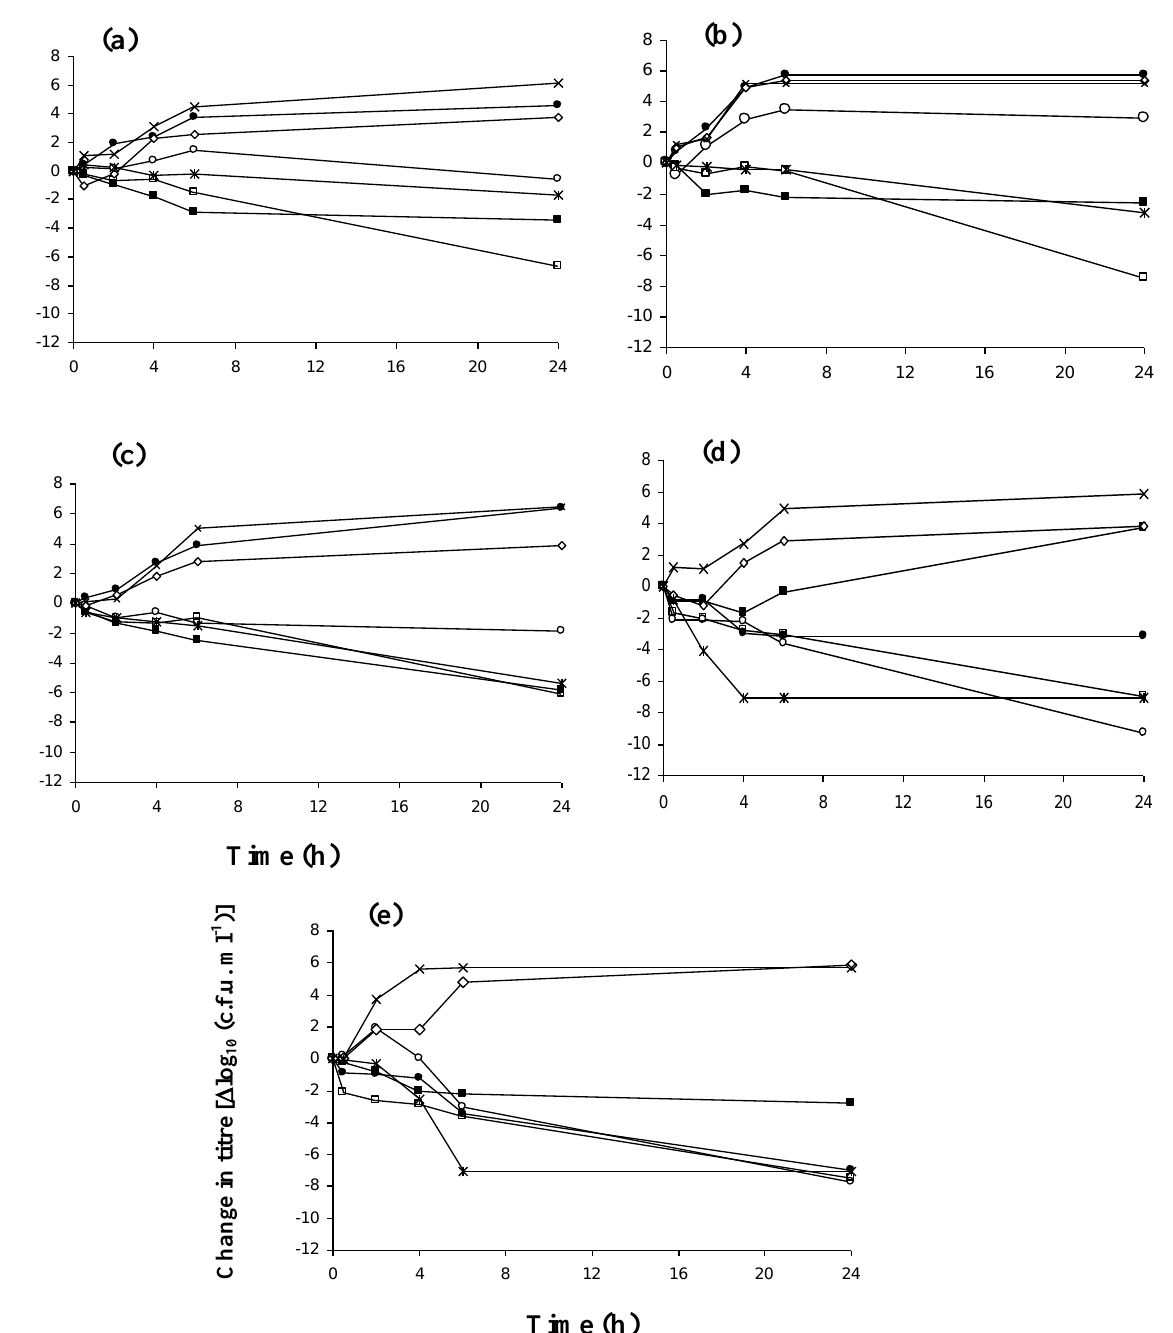
Figure 1. The bactericidal activities of the antimicrobial dressings against five microorganisms. Values are the means of three experiments performed in triplicate.  log 10 c.f.u. ml -1 is the difference in  log c.f.u. ml -1 at the time of bacterial inoculation, starting 10 from t = 0. Strains: ( a ) Methicillin-sensitive Staphylococcus aureus (ATCC 6338P); ( b ) Methicillin-resistance Staphylococcus aureus (ATCC 25923); ( c ) Bacillus subtilis (ATCC 6633); ( d ) Pseudomonas aeruginosa (ATCC 27853); ( e ) Escherichia coli (ATCC 25922) and □ represents Acticoat  ; ○ represents Aquacel Ag  ; * represents Askina Calgitrol Ag  ; ■ represents Bactigras  ; ● represents Urgotul SSD  ;  represents Mepitel  and  represents growth